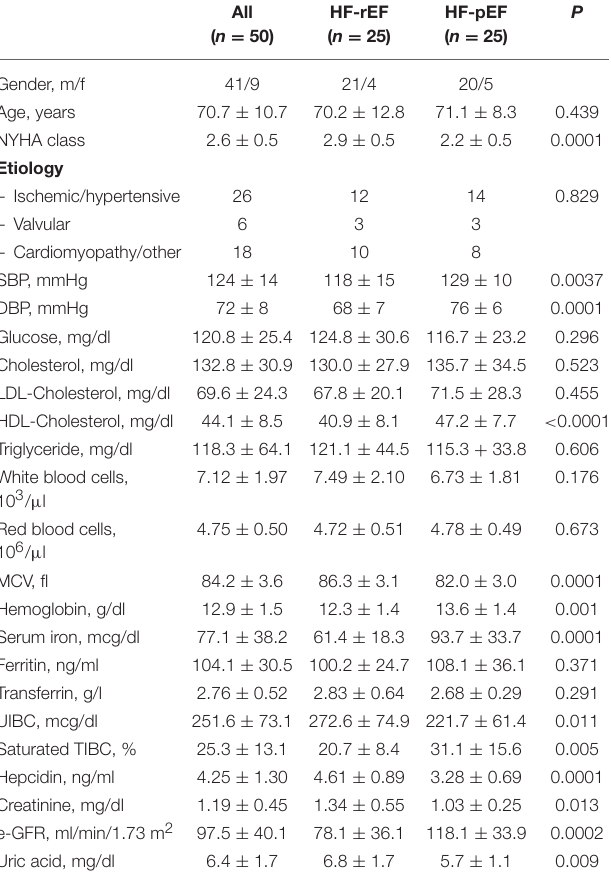
TABLE 1 | Anthropometric, biochemical and hemodynamic characteristics of the whole study population and of the two groups separately. All ( n = 50)